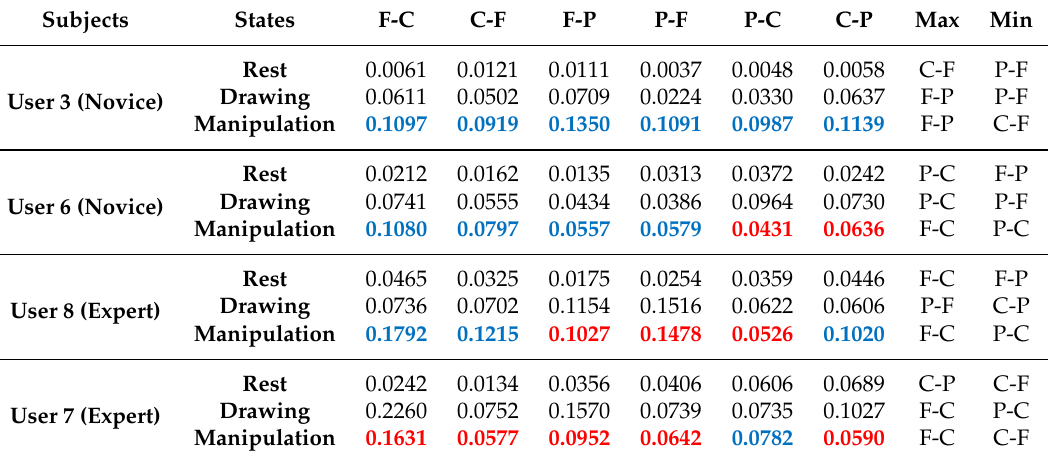
Table 5. Information flow among F, C and P nodes during rest, drawing and manipulation